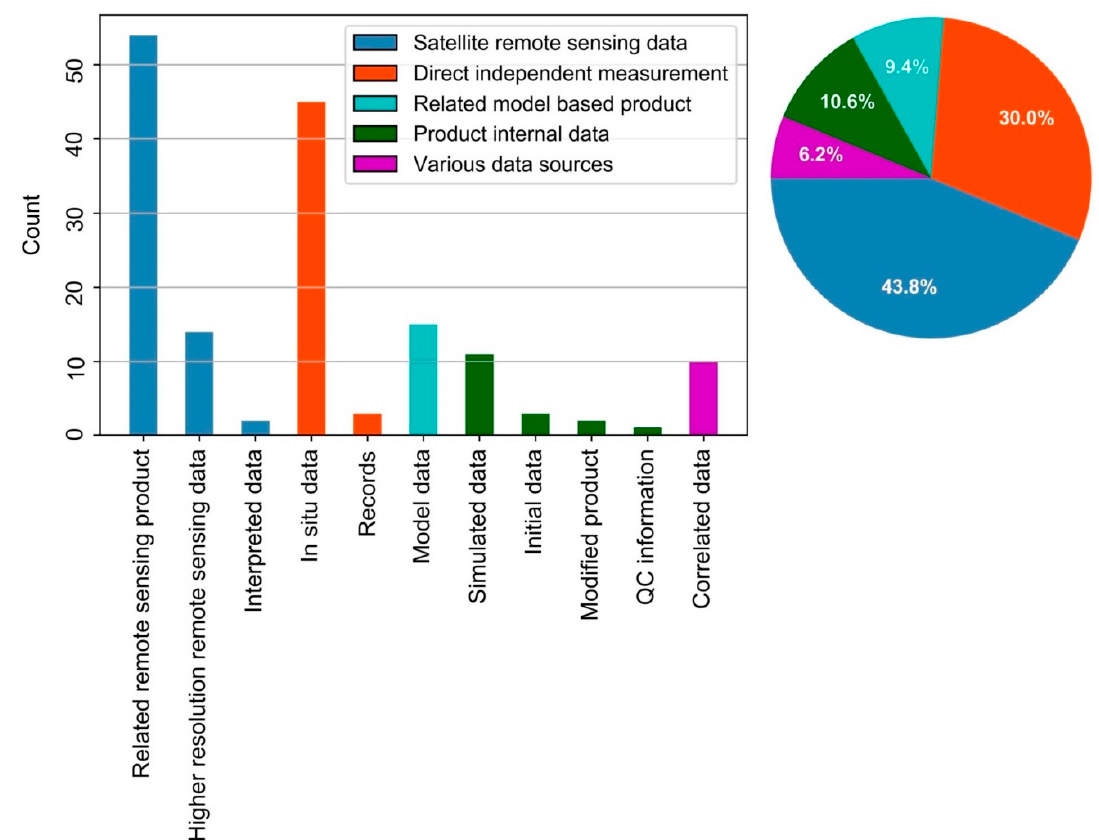
Figure 11. Validation data used in the studies grouped by source.